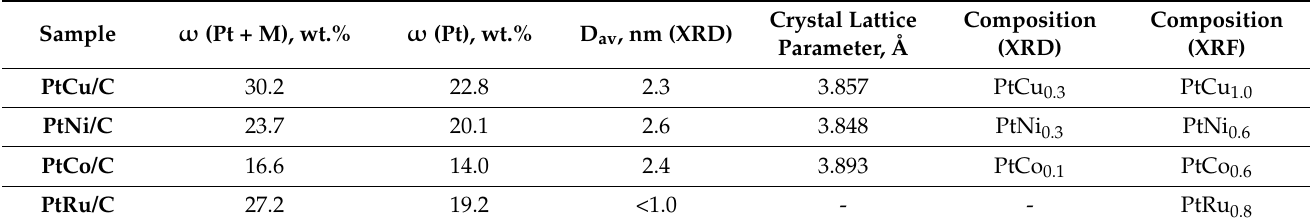
Figure 1. The X-ray diffraction patterns of the obtained PtM/C catalysts: 1 —PtRu/C; 2 —PtCo/C; 3 —PtCu/C; 4 —PtNi/C. Table 1. The composition and the structural characteristics of the obtained PtM/C